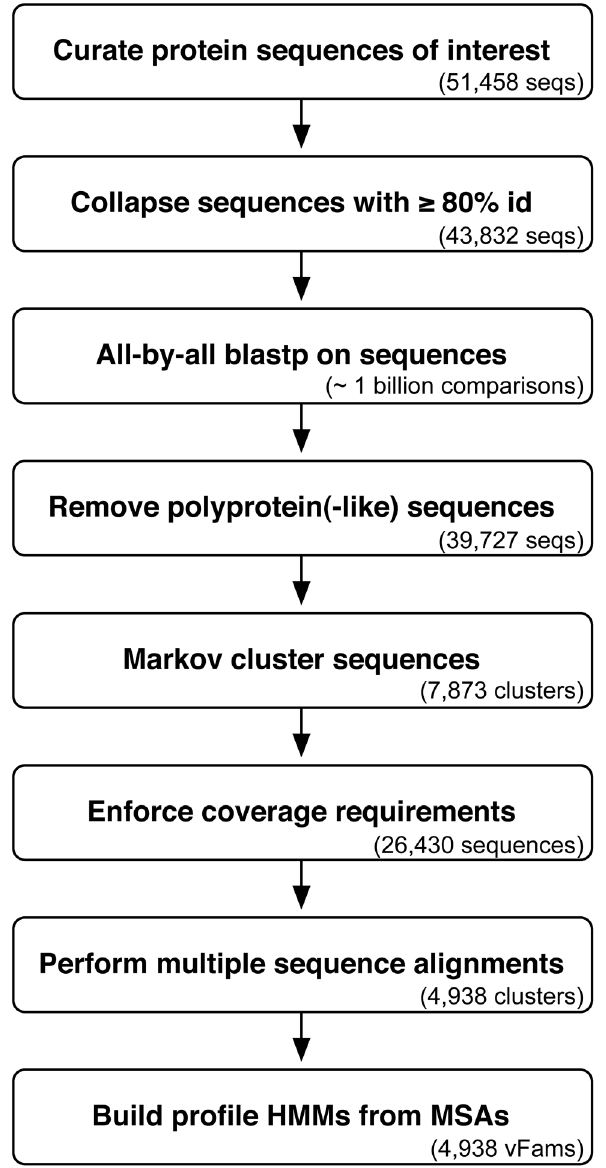
Figure 1. The pipeline for building profile HMMs from a set of curated viral protein sequences. An initial set of protein sequences of interest is curated and reduced by collapsing high-identity sequences. The similarity between all pairs of remaining sequences is calculated using BLAST. Using the BLAST results, polyprotein sequences are inferred and removed. The Markov Clustering algorithm groups the remaining sequences into families. Sequences with extreme lengths are removed before multiple sequence alignments are generated for each family. Multiple sequence alignments are used to train profile HMMs. Statistics for each step in the generation of the vFams are in parentheses.